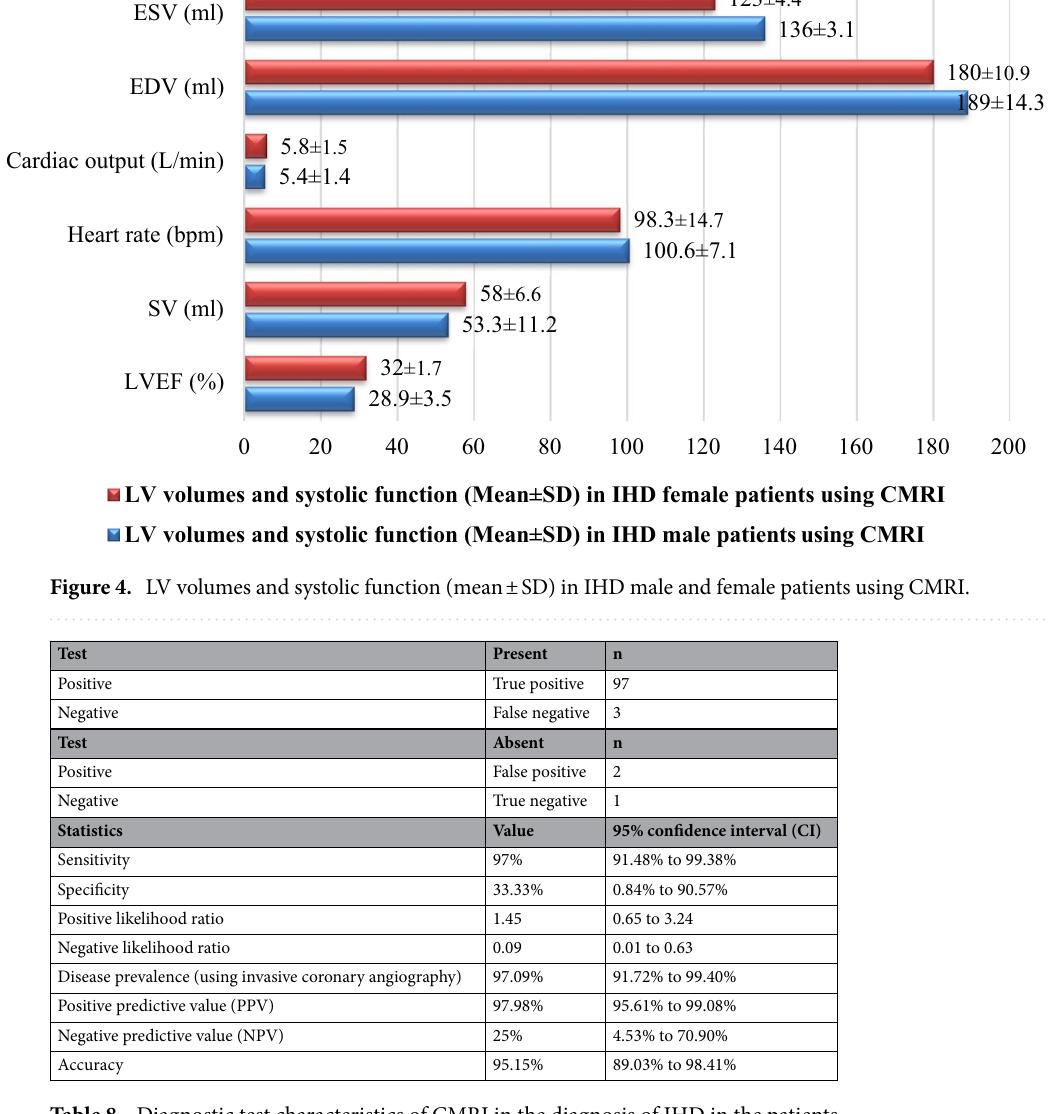
Table 8. Diagnostic test characteristics of CMRI in the diagnosis of IHD in the